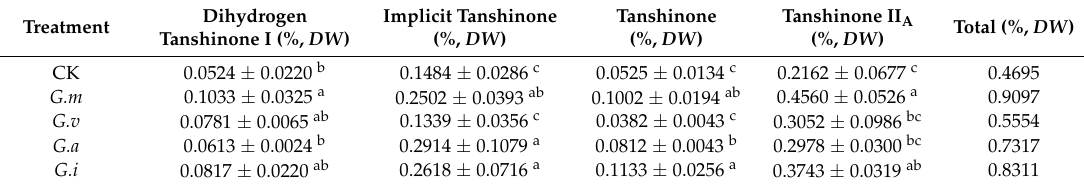
Table 7. Effect of AMFs on tanshinones concentration of S. miltiorrhiza seedling roots. Treatment